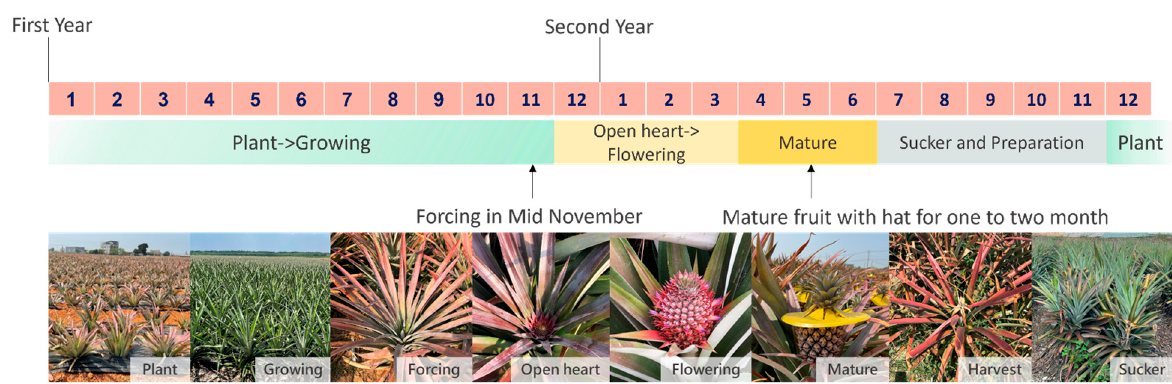
Figure 2. The phenological growth stages of pineapple in the study area.